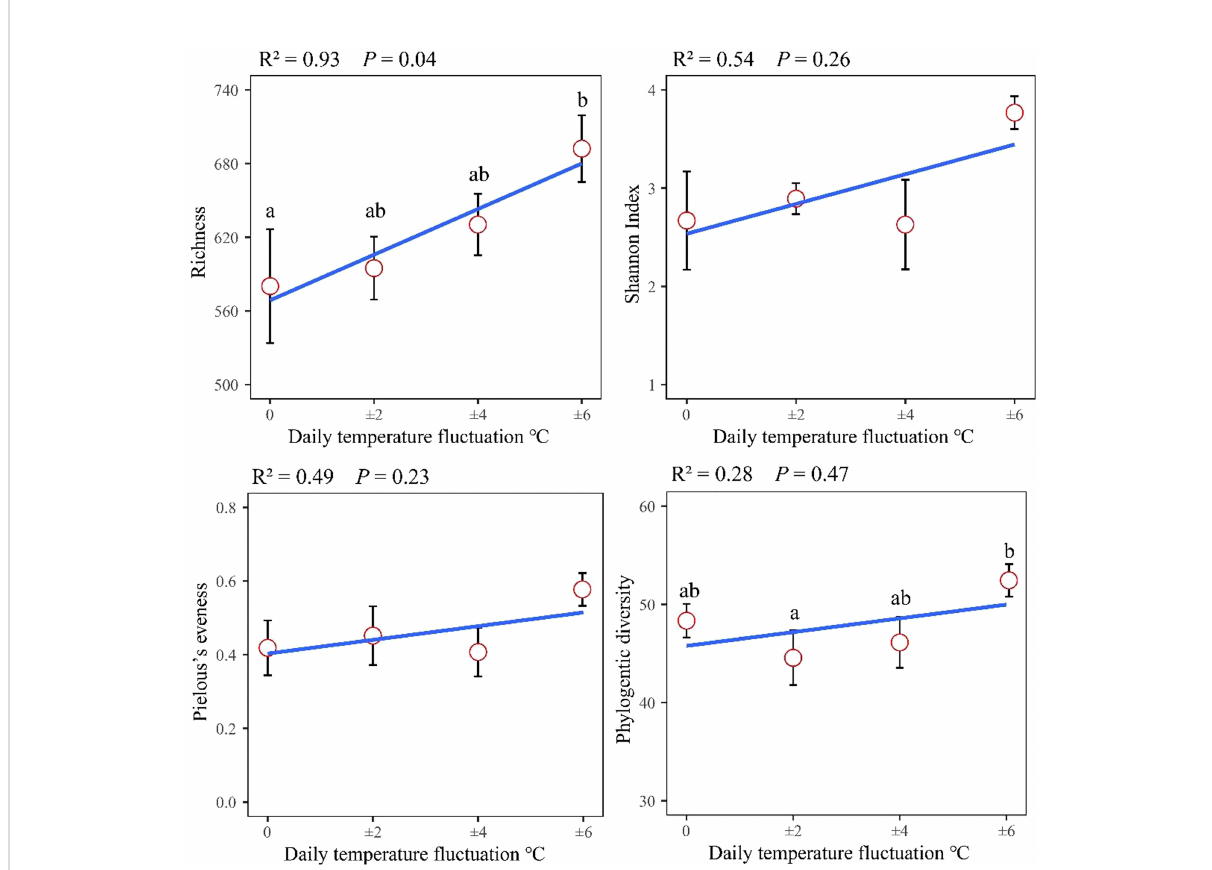
FIGURE 6 a -diversity index in gut microbes of juvenile crabs. Values are expressed as mean ± SD (n = 3). Different superscripts indicate signi fi cant differences between treatments ( P < 0.05). R 2 and P values after linear regression analysis showed the correlation between a -diversity indices and DTF.